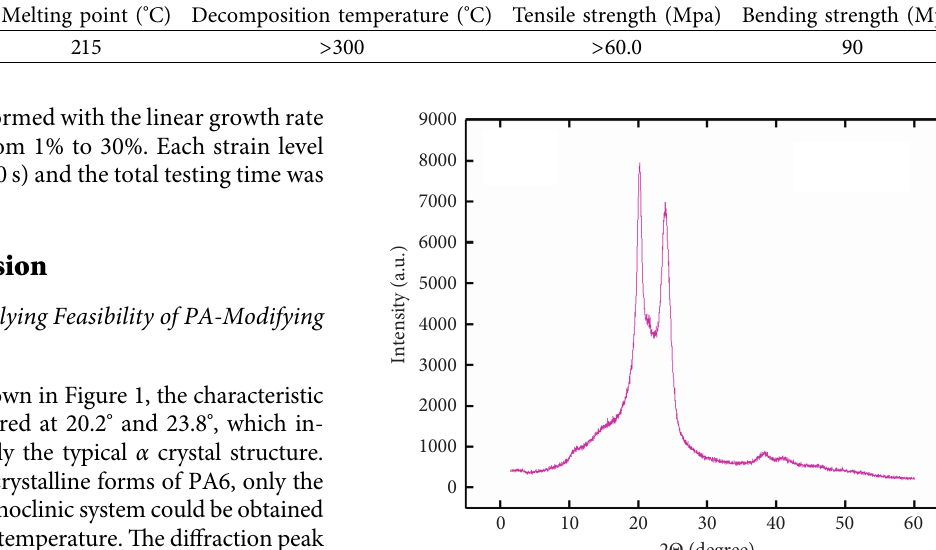
Table 2: Technical properties of PA6.